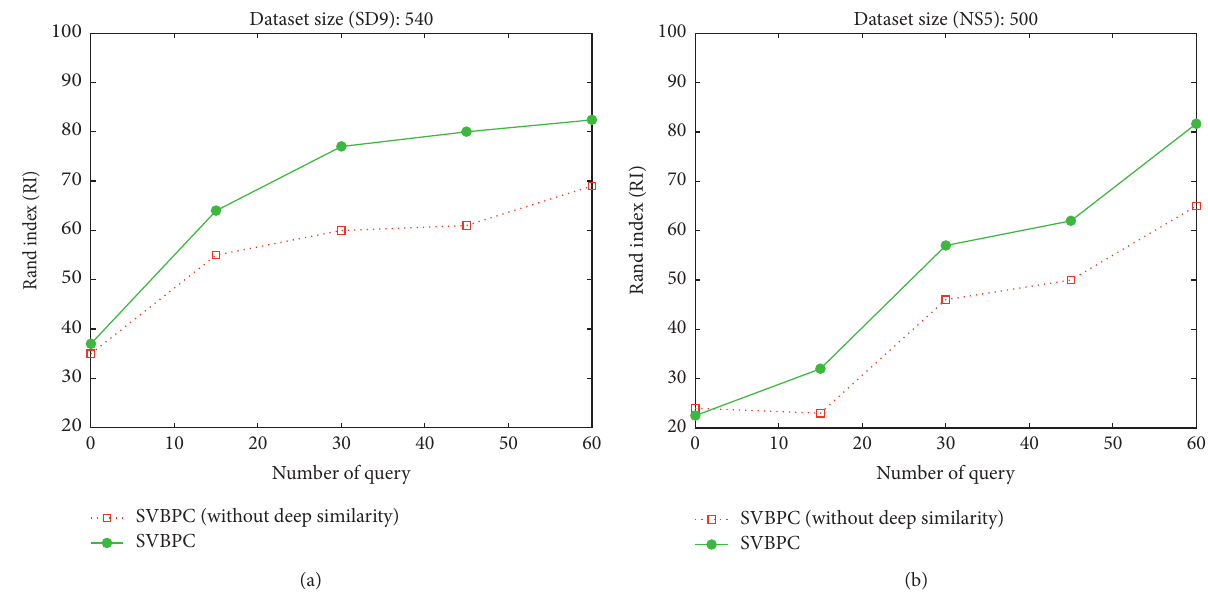
Figure 4: RI details on the proposed algorithm with and without